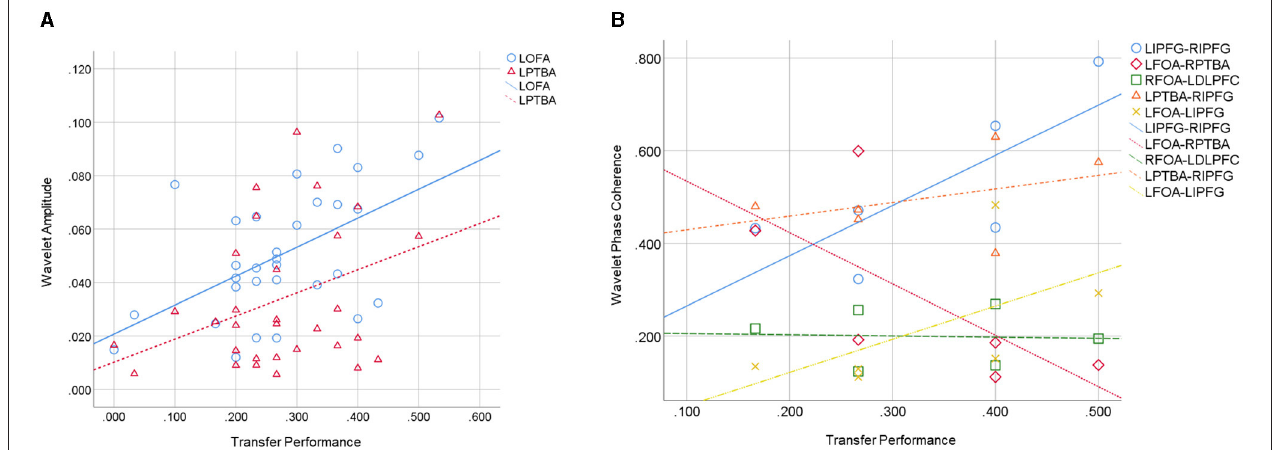
FIGURE 10 | Scatter diagram of Pearson correlation analysis between transfer performance and functional connectivity. (A) Wavelet amplitude; (B) wavelet phase